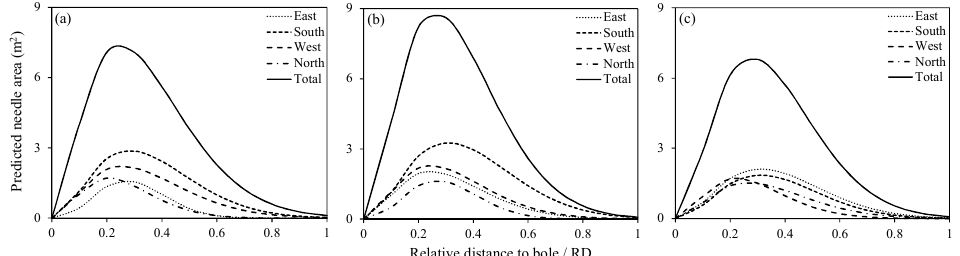
Figure 7. Horizontal distribution of the predicted NA, according to the relative distance from the bole (RD) at intervals of 0.1 in different directions, for three sample trees: ( a ) tree 1; ( b ) tree 2 and ( c ) tree 3.